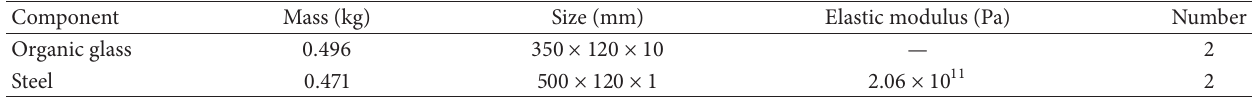
Table 1: Parameters of the structural model.